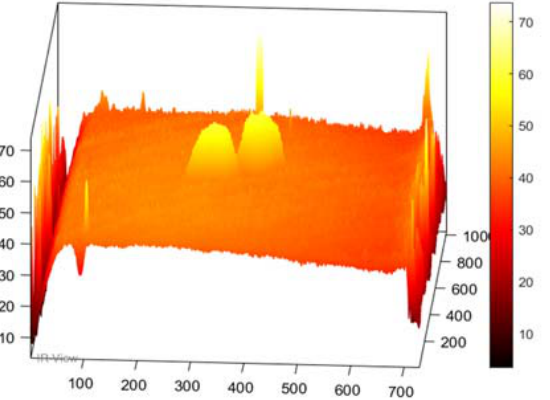
Figure 6. Three-dimensional image, corresponding to PPT.